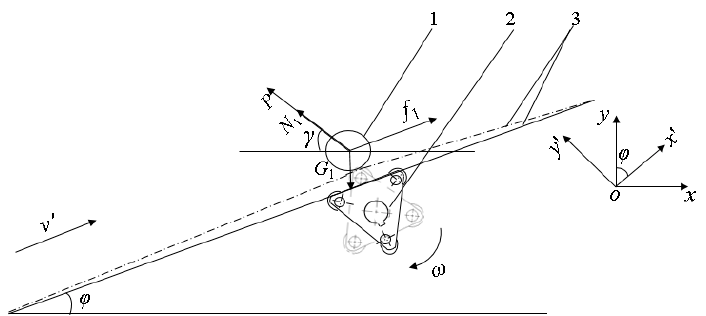
Figure 6. Stress analysis of the mixture on the hoisting devices. 1. Mixture of tiger nuts, soil, and stalks; 2. Vibrating drum; 3. Screen. φ , γ , and 𝑣 , separately represent the angle between hosting devices and horizontal plane (°), the intersection angle between the hoisting devices and the horizontal plane (°), and the linear velocity of the hoisting chains (m/s); f 1 , N 1 , P , and G 1 separately represent the frictional force (N), supporting force (N), centripetal force (N), and gravitational force (N) on the mixture, respectively.